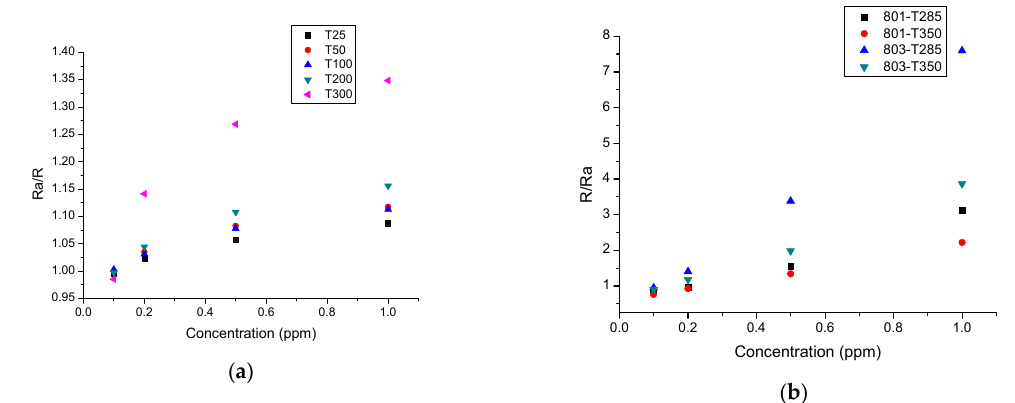
Figure 4. ( a ) Response of the pure pristine graphene device at different temperatures; ( b ) response of the commercial microsensors at different